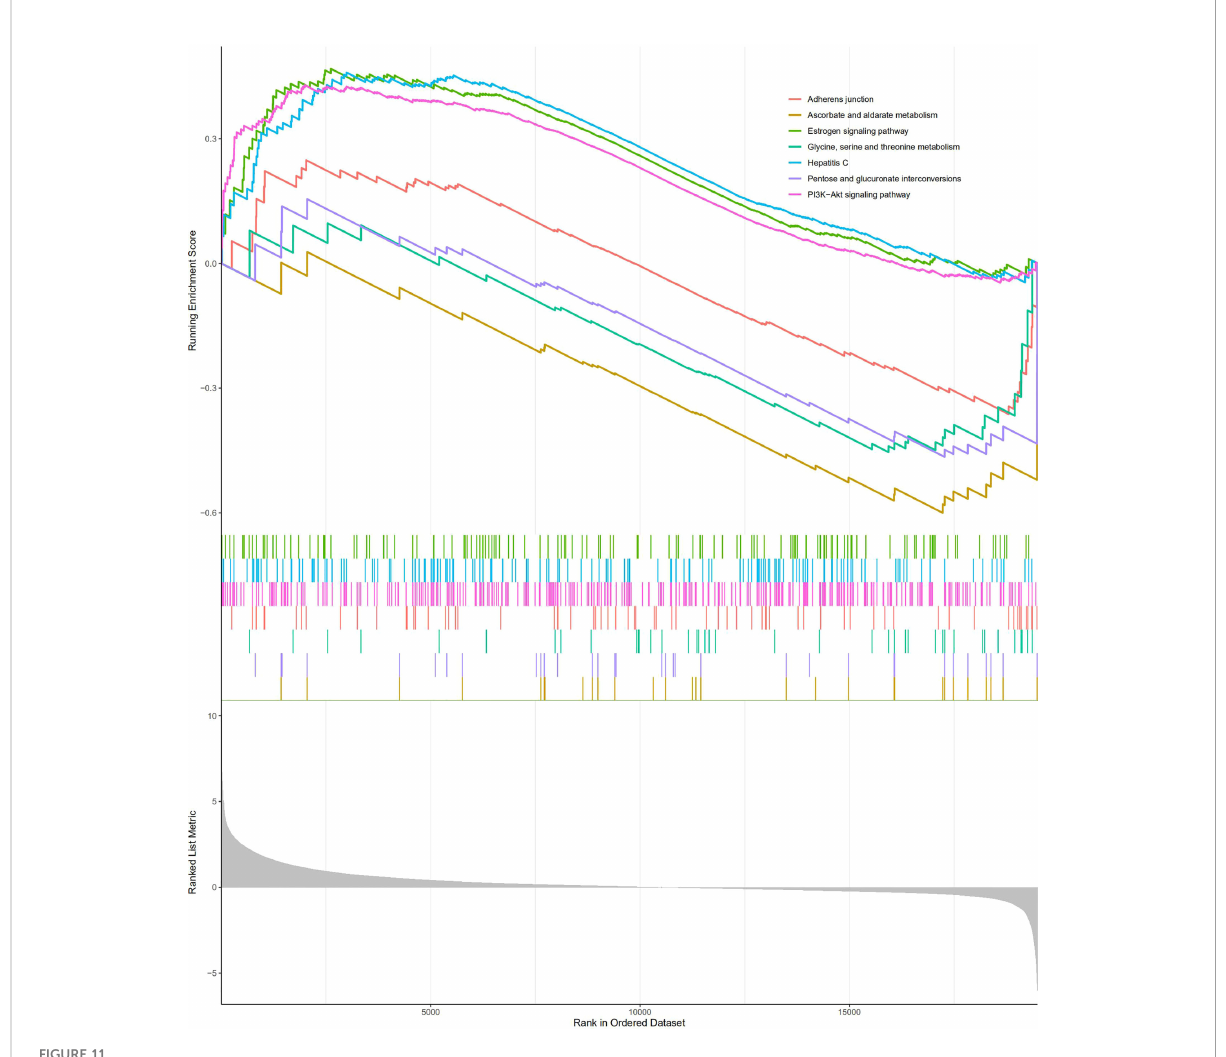
FIGURE 11 Gene Set Enrichment Analysis